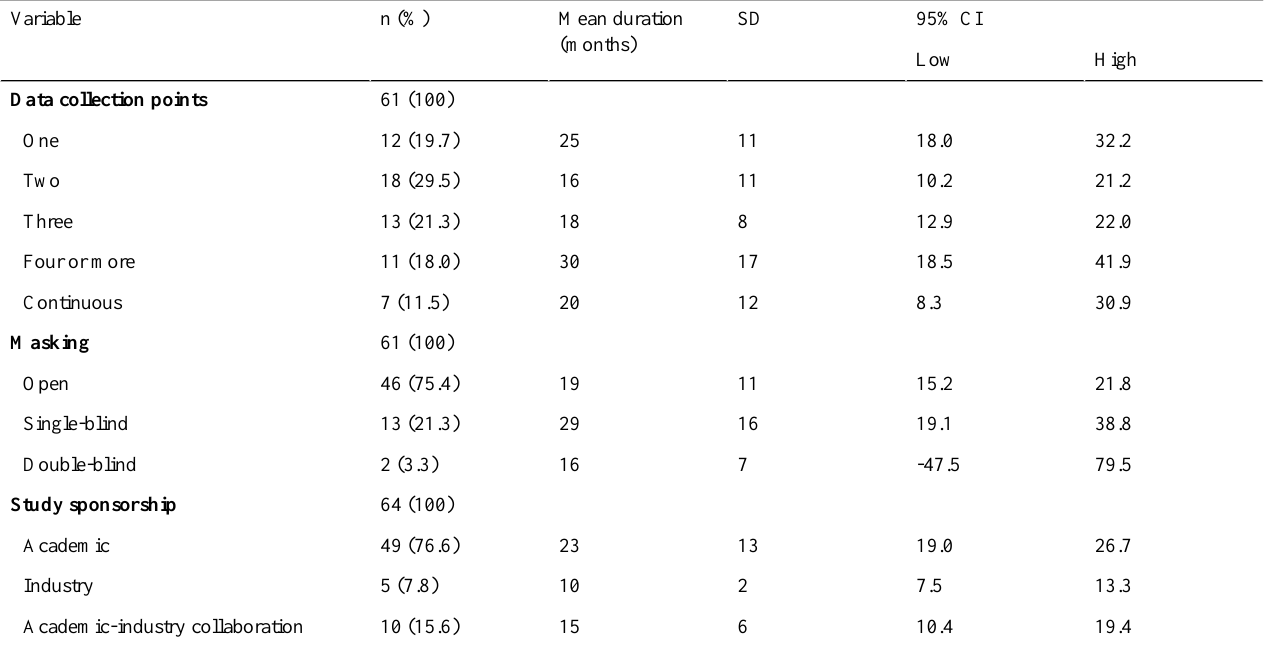
Table 5. Study duration means of trials included for analysis grouped by data collection frequency, masking, and study